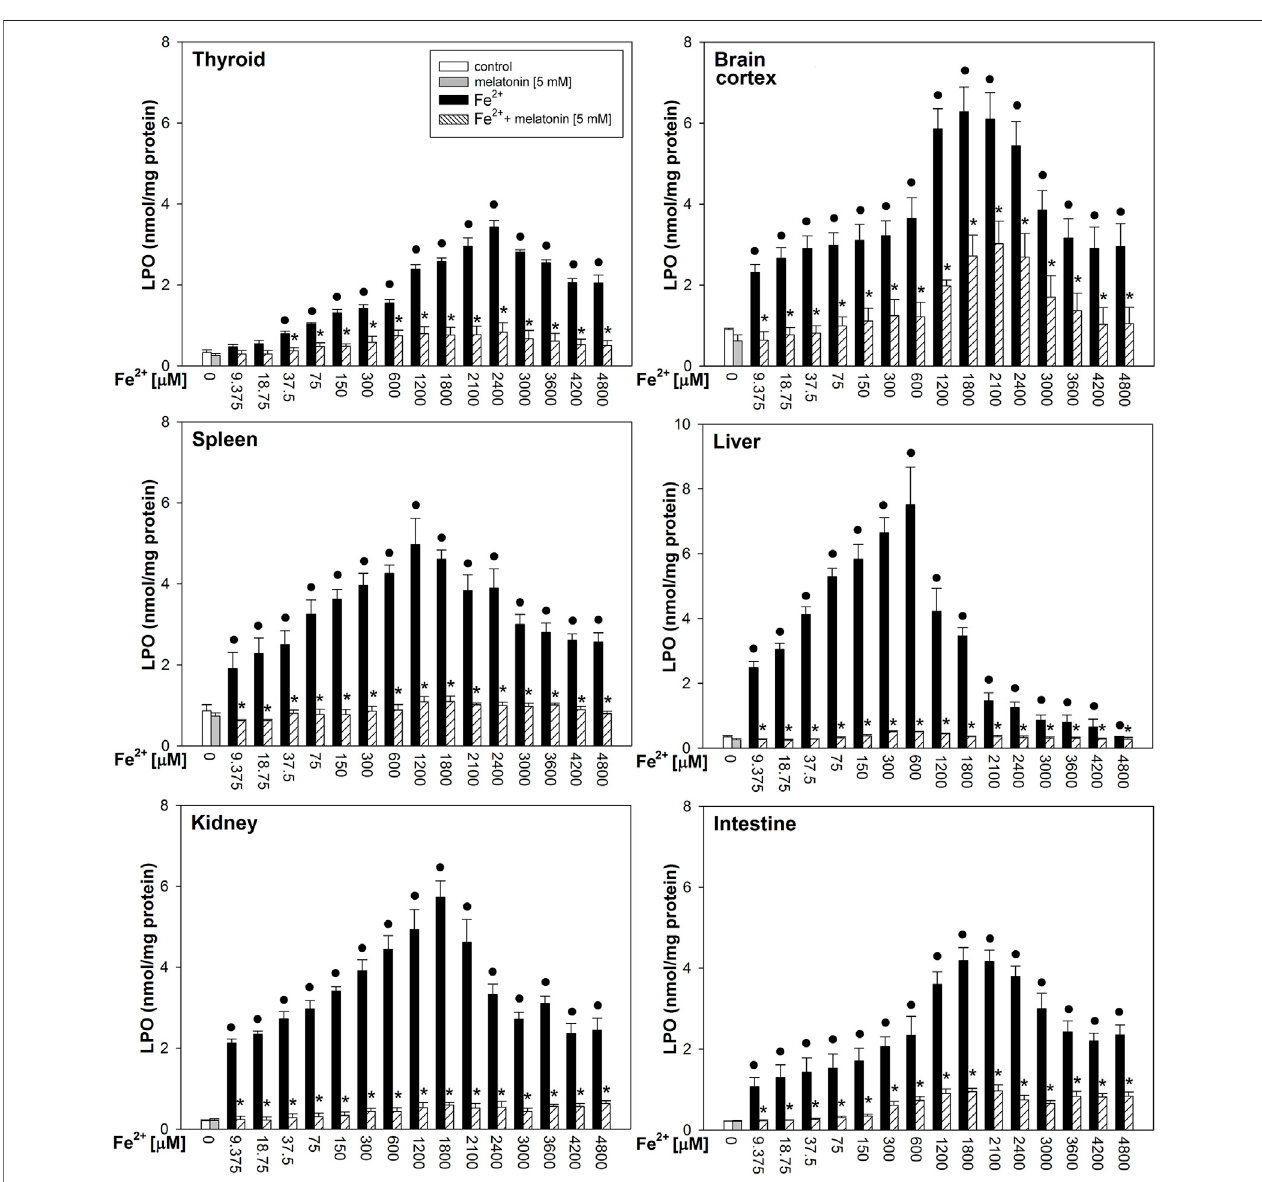
FIGURE 2 | Concentrations of lipid peroxidation products (MDA+4-HDA) in the homogenates of porcine tissues (thyroid, brain cortex, spleen, liver, kidney, and intestine), incubated without any substance (control; white bars) or with melatonin (5 mM) (gray bars) or with Fe 2+ (9.375, 18.75, 37.5, 75, 150, 300, 600, 1,200, 1,800, 2,100, 2,400, 3,000, 3,600, 4,200, and 4,800 µM) + H 2 O 2 (5 mM) (black bars) or with Fe 2+ (9.375, 18.75, 37.5, 75, 150, 300, 600, 1,200, 1,800, 2,100, 2,400, 3,000, 3,600, 4,200, and 4,800 µM) + H 2 O 2 (5 mM) withmelatonin (5 mM) (striped bars). p < 0.05 vs. respective control(withoutany substance); * p < 0.05 vs. Fe 2+ in the same concentration. Statistical differences between Fe 2+ +H 2 O 2 +melatonin (stripped bars) vs. melatonin (gray bars) in particular tissues are not marked.